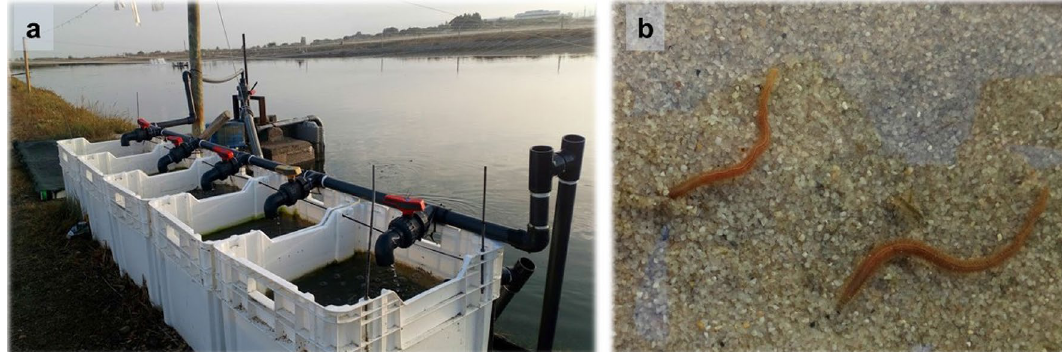
Figure 5. ( a ) Polychaete assisted sand filters (PASF) used in the present study; ( b ) Hediste diversicolor in sand